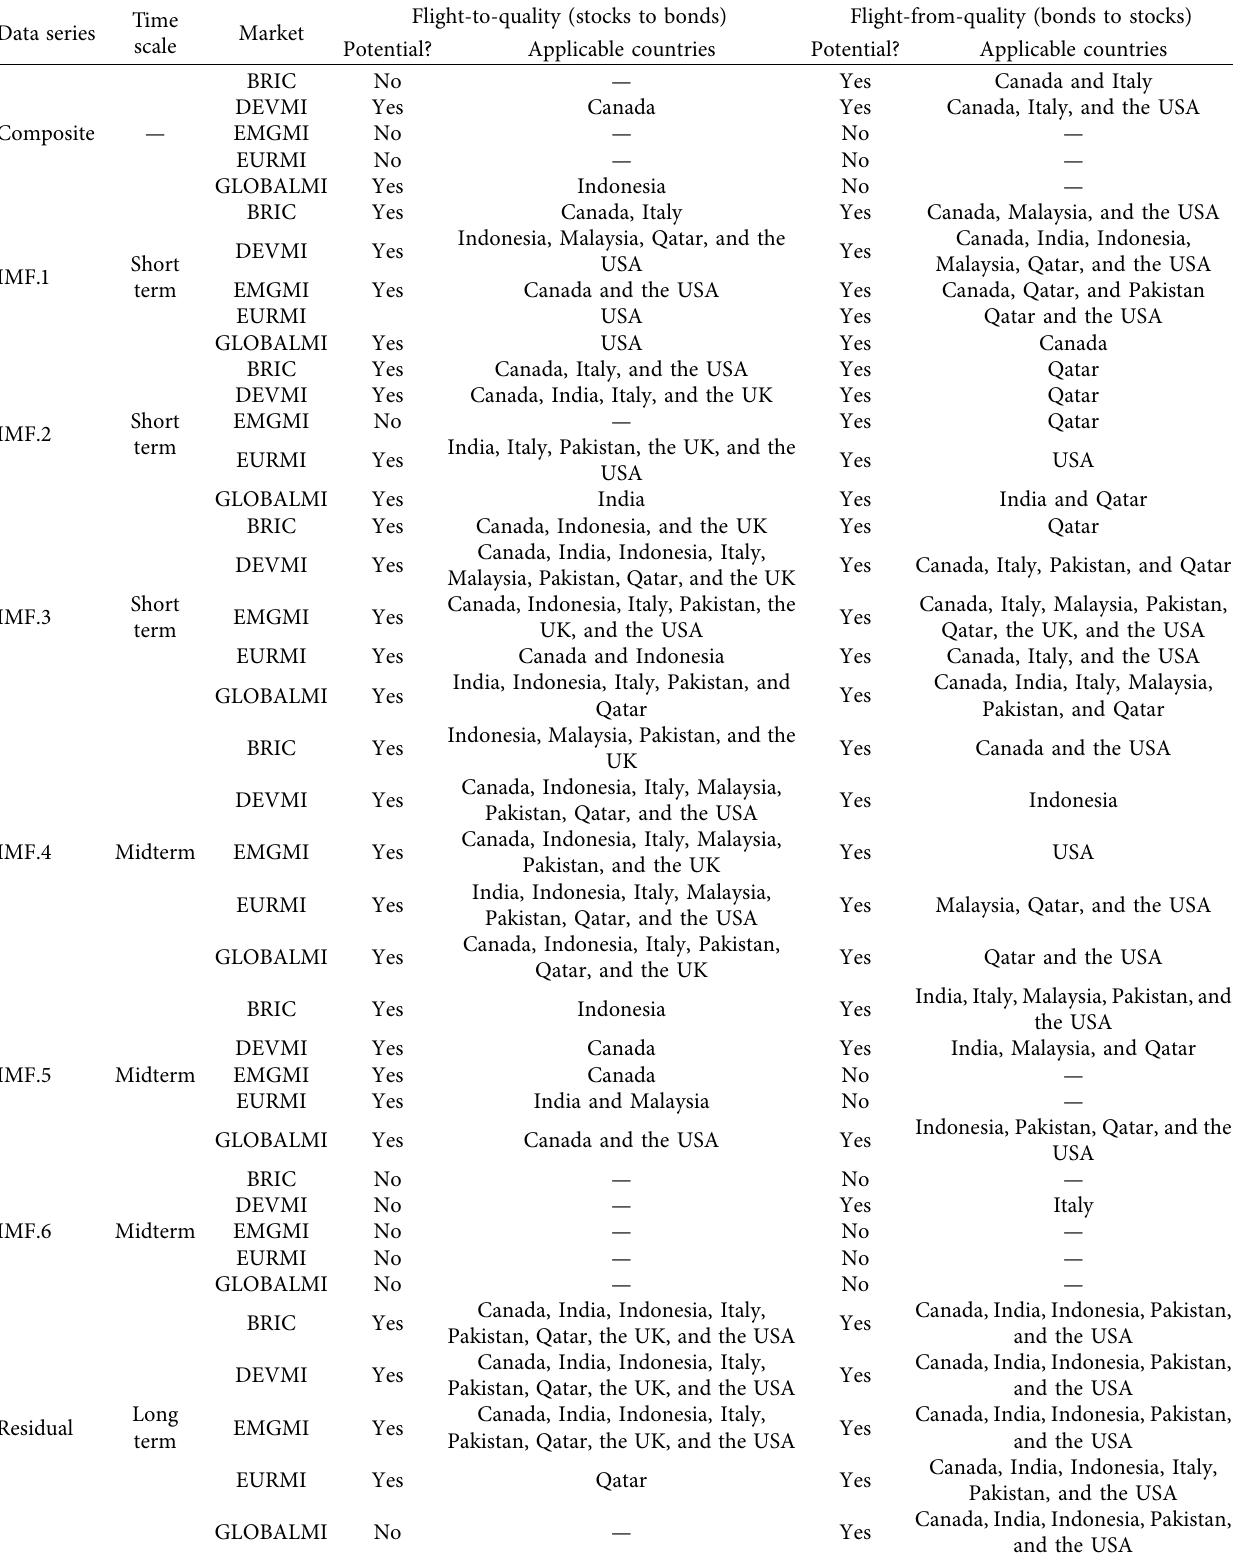
Table 3: Summary of flight-to-quality and flight-from-quality prospects between global equities and Islamic and conventional bonds. Data series